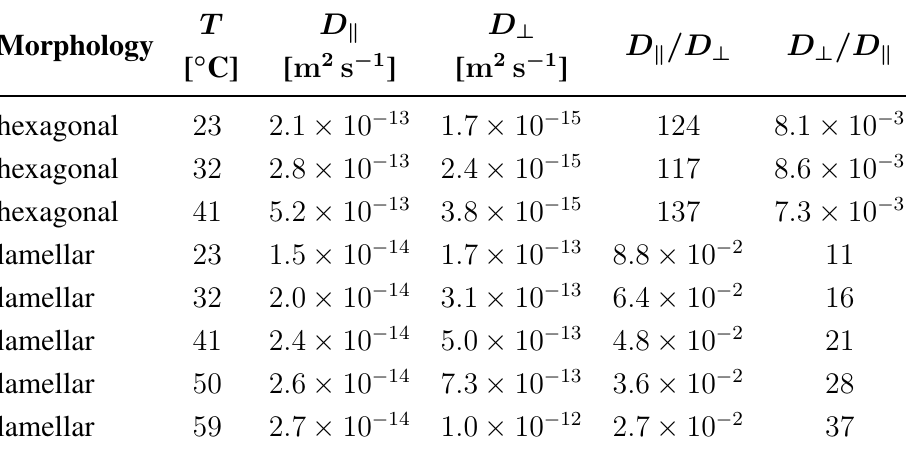
Table 2. The diffusion coefficients evaluated from the fits of Equation (6) to the experimental data represented in Figure